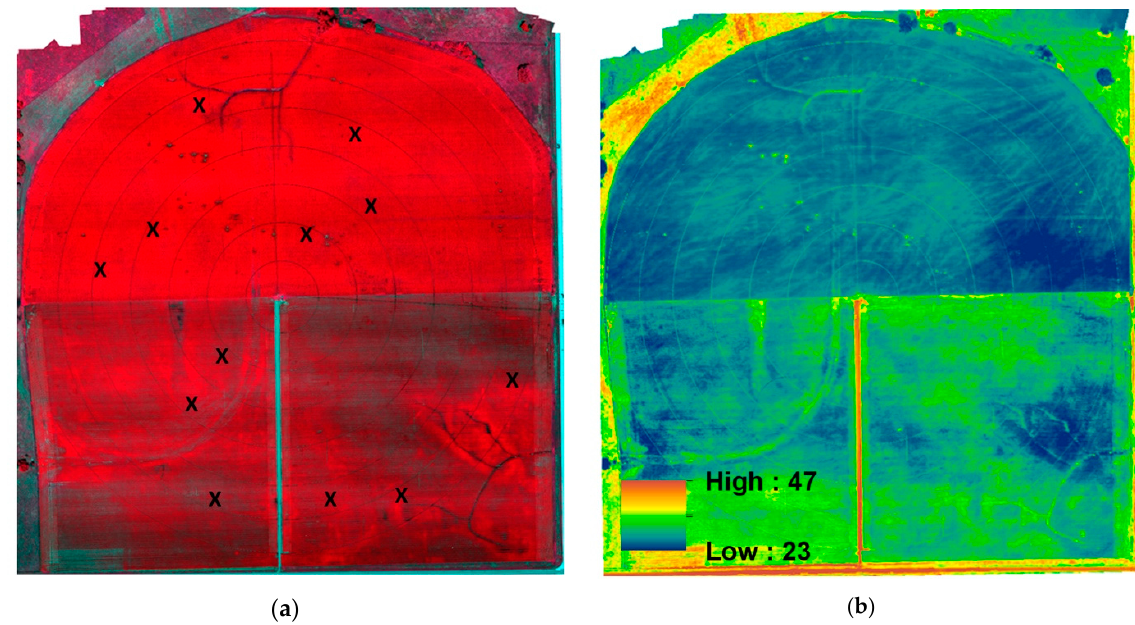
Figure 1. ( a ) UAS multispectral color infrared ortho-images; ( b ) thermal infrared (°C) ortho-images. Color infrared image depicts location of IRT sensors denoted with X. Table 1. FLIR Duo Pro R thermal camera specifications. Table 3. Dates of UAS image